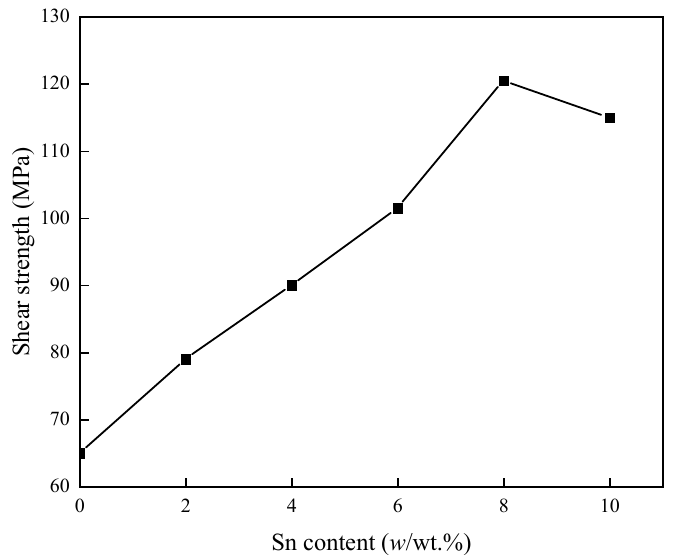
Figure 17. Relationship between the shear strength of Cu/304 stainless steel brazed joints and the content of Sn in the applied amorphous Cu-5P-2Ni brazing filler metals [49].